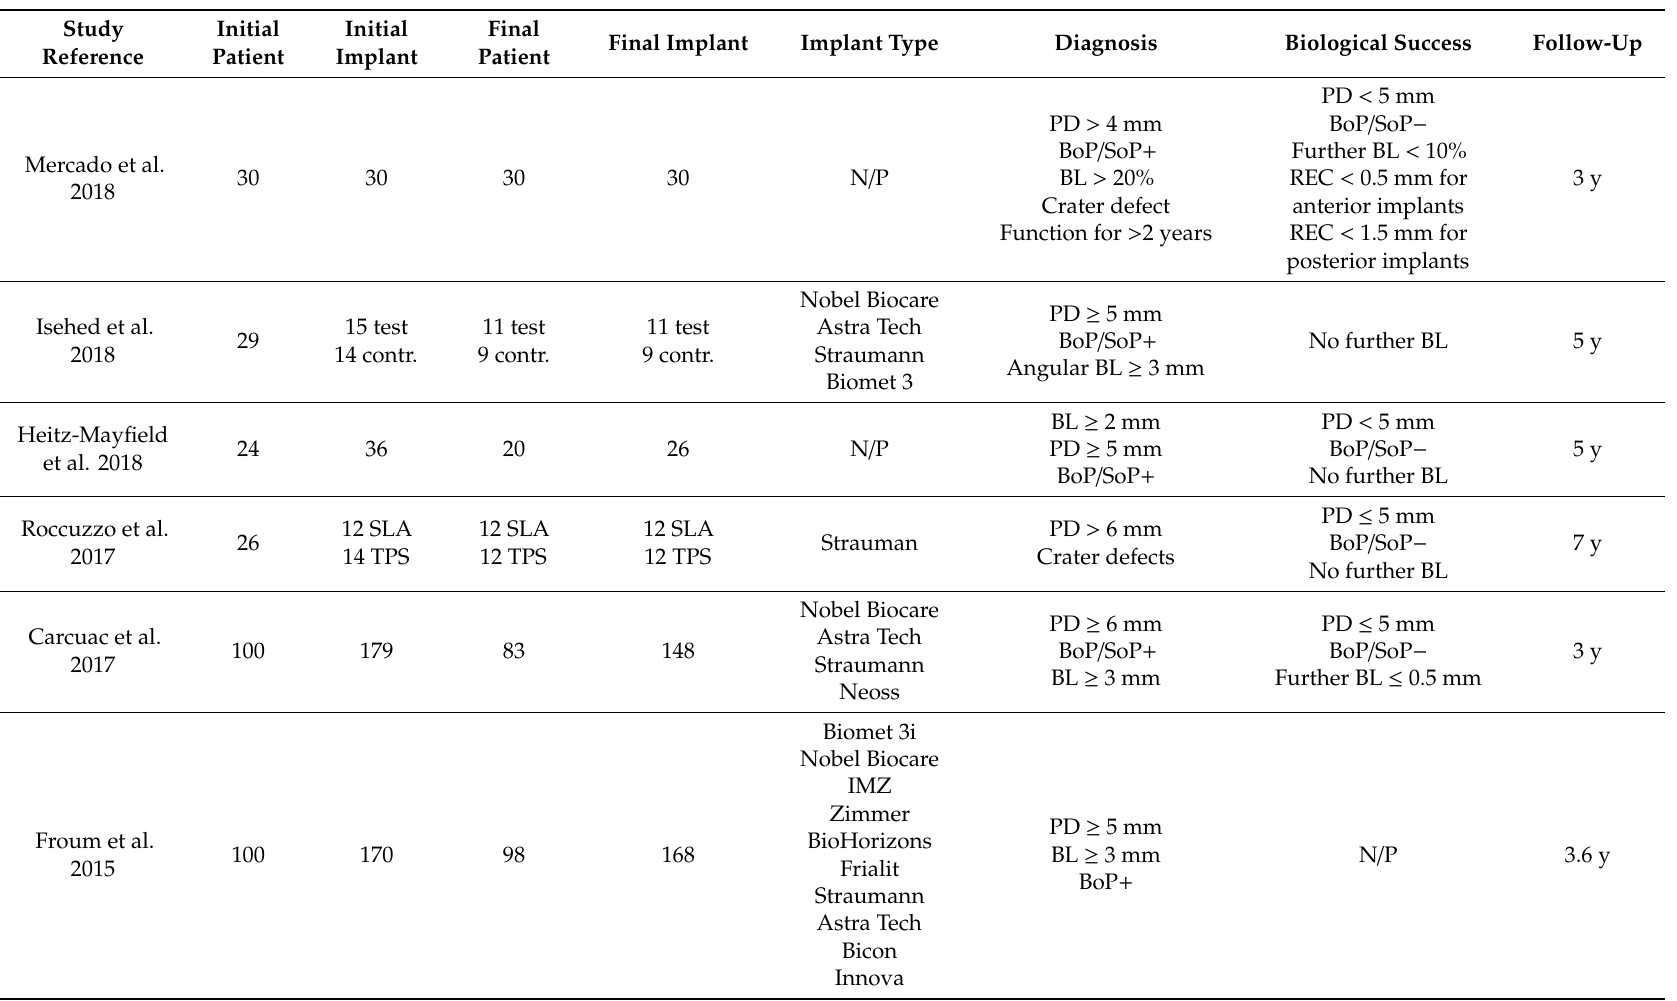
Table 2. Demographics and diagnostic criteria of included articles. Abbreviations, BoP: bleeding on probing ( +/ − ). BL: bone loss (mm). N / P: not provided. PD: probing depth (mm). REC: recession (mm). SLA: sandblasted acid-etched. SoP: suppuration on probing ( +/ − ). TPS: titanium